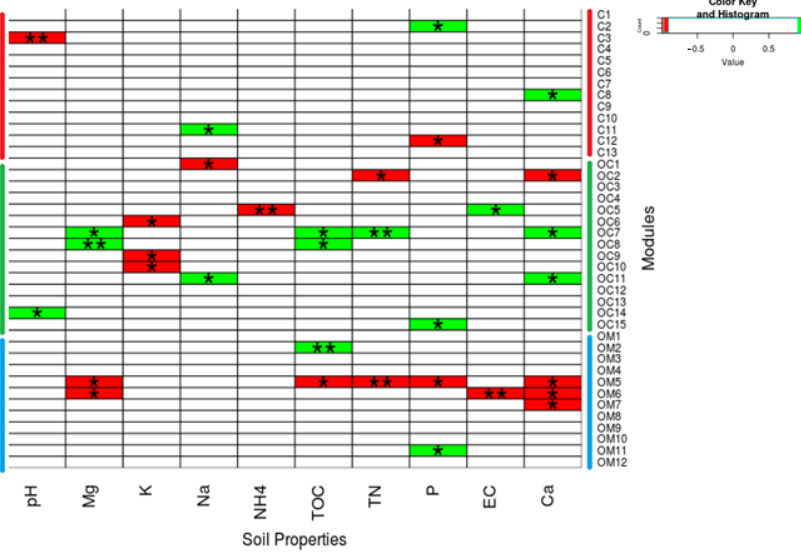
Figure 4. Heat map showing significant module correlation between soil properties and the modules in the Org_C, Org_M and Conv cropping systems. Colors represent positive (green) or negative (red) correlations, and the star symbol (*) in the cells represents the significance of that correlation, with *, p < 0.05; **, p < 0.01. Conv, conventional cropping system; Org_C, organic cropping system with compost and compost tea; Org_M, organic cropping system with manure; TN, total nitrogen; TOC, total organic carbon; Mg, K, P, Na and Ca; available Mg, K, P, Na and Ca, respectively; EC, electrical